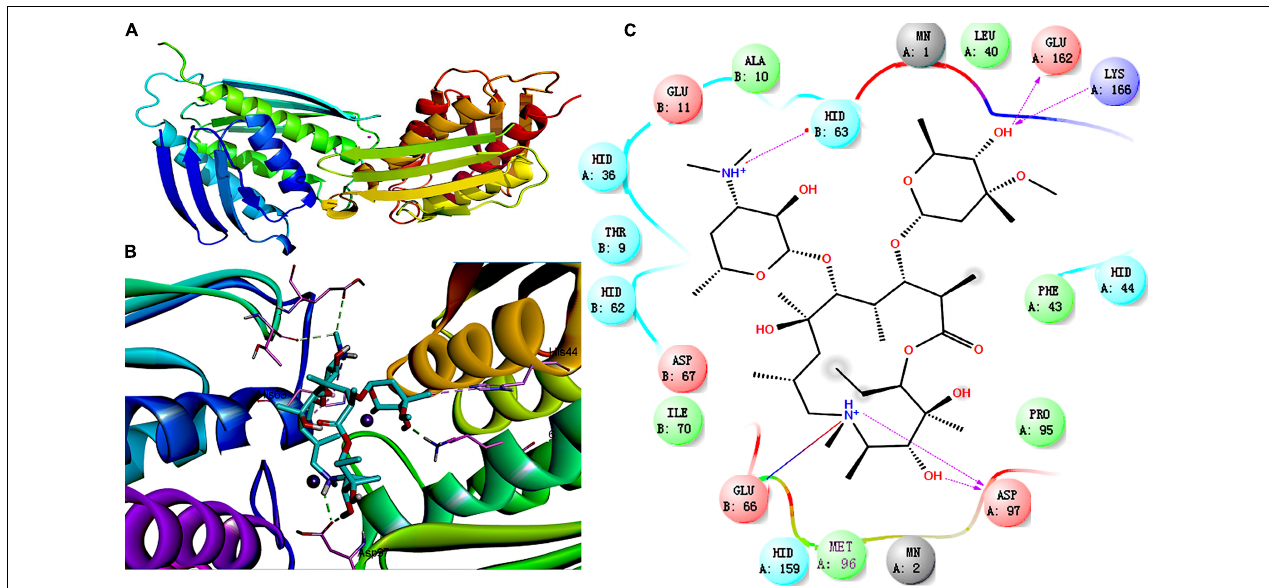
Figure 3 | Molecular docking between IGPD and azithromycin. (A) Superposition of ligand-free dimers of IGPD, showing different flap conformations. (B) 3D-docked images of azithromycin with IGPD. (C) Binding interactions between IGPD and azithromycin. Purple lines, H-bond; red lines, salt bridge